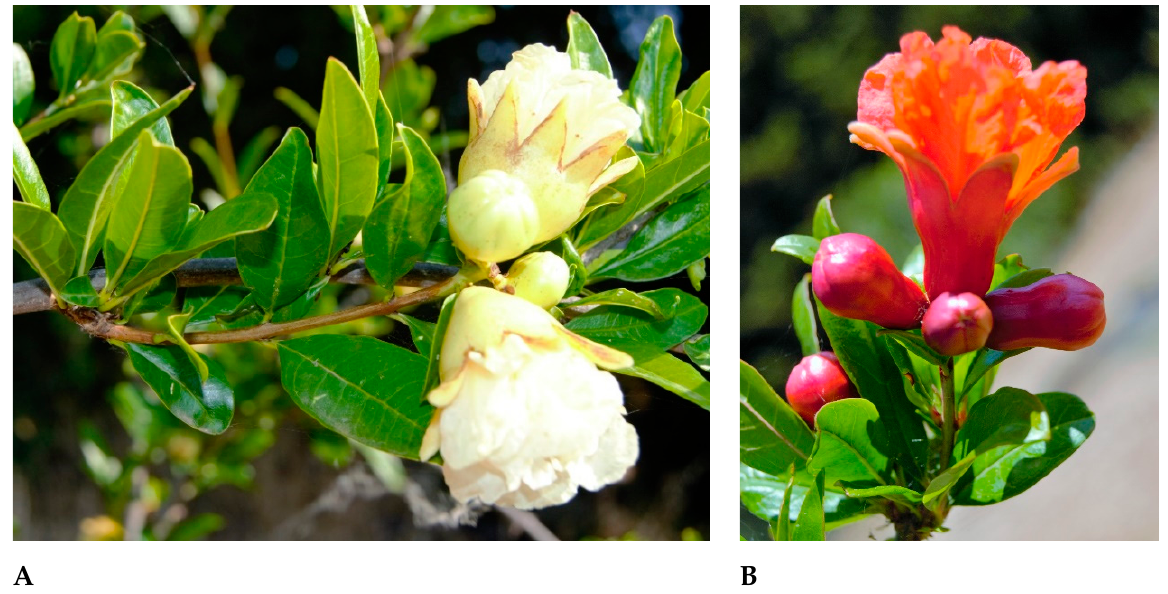
Figure 3. Mixed buds developing a long shoot in ‘Haku Botan’ ( A ) and a short shoot in ‘Comune S. Giorgio’ ( B ).